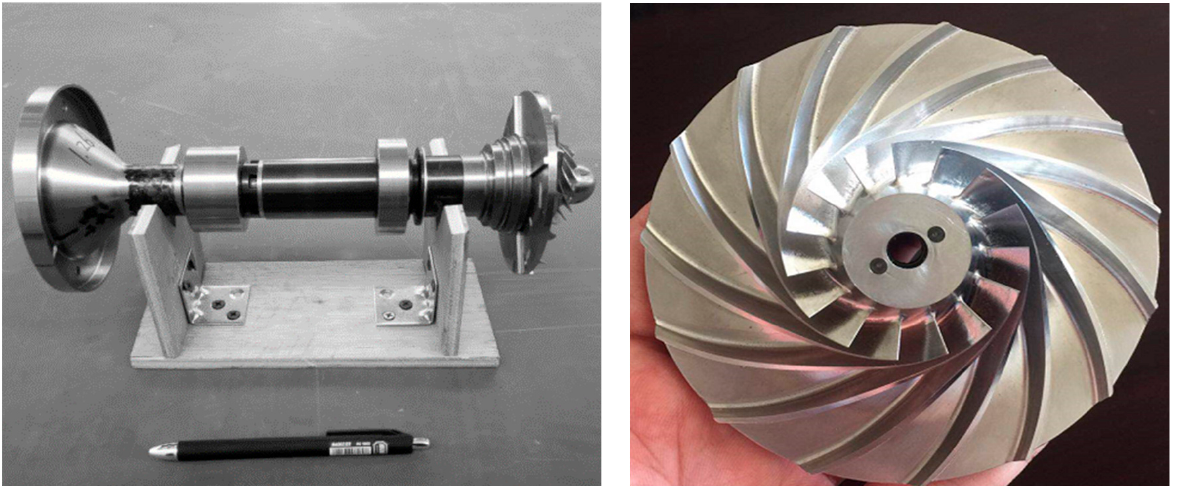
Figure 5. Schematic figure of the rotor ( left ) and impeller ( right ).